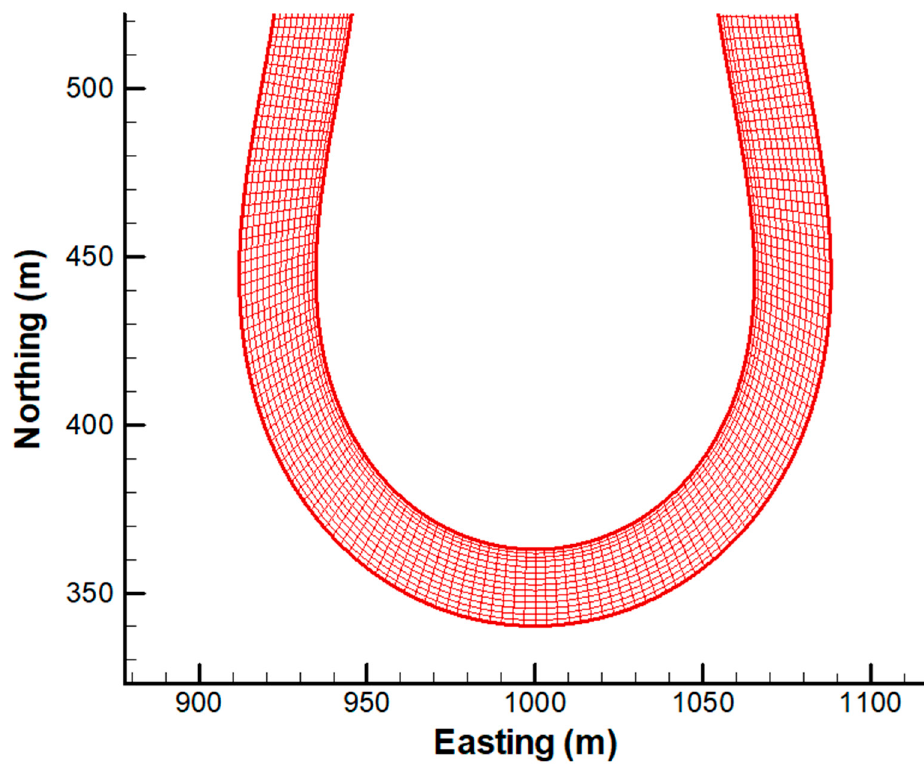
Figure 23. Plan view of the structured 2D model mesh domain for Simulation Set 5 with a sinuosity of 2.75.